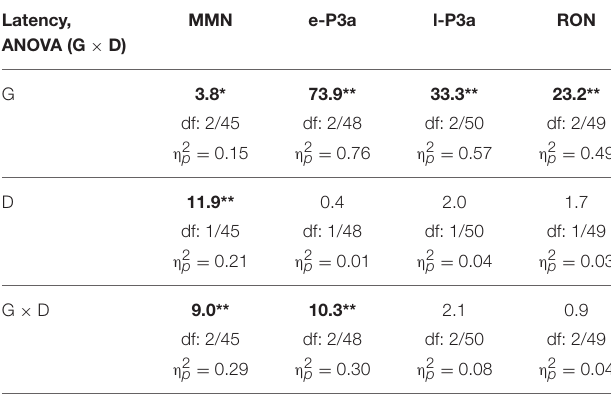
TABLE 4 | F -values from two-factor ANOVAs (Group × Difference) for MMN, e-P3a, l-P3a, and RON latencies.